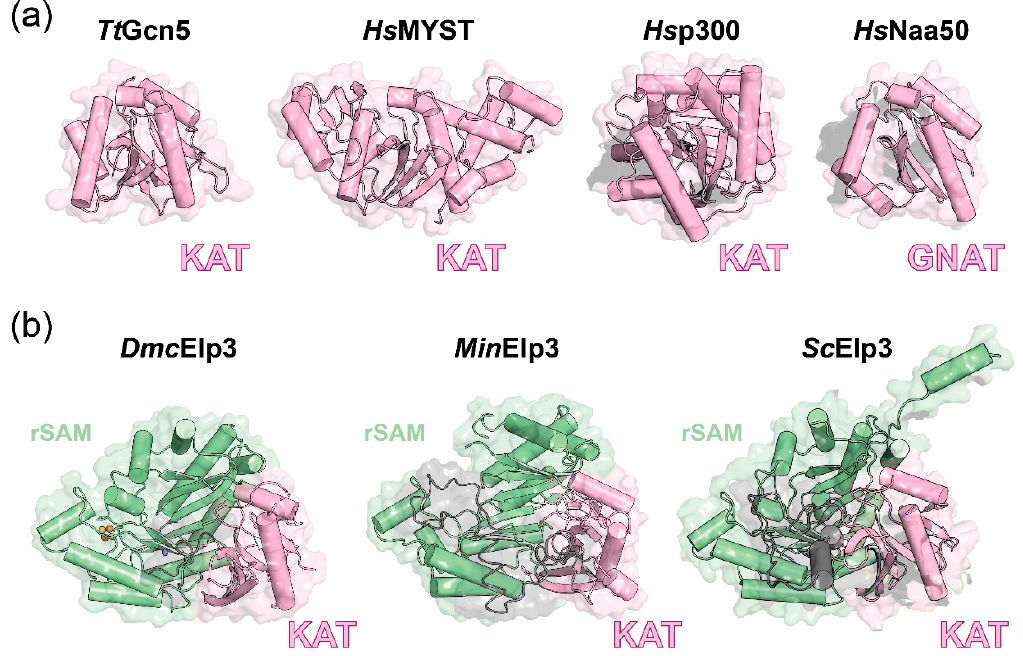
Figure 1. Protein acetyltransferases and Elp3s structures. ( a ) Structures of KAT domain from TtGcn5 (PDB: 1QSN), HsMYST (PDB: 2PQ8), and Hsp300 (PDB: 5LKT) and the GNAT domain from HsNaa50 (PDB: 6PPL). ( b ) Elp3 structures from D. mccartyi (PDB: 5L7J), M. infernus (PDB: 6IAD), and S. cerevisiae (PDB: 6QK7). Domains of each enzyme are as indicated.